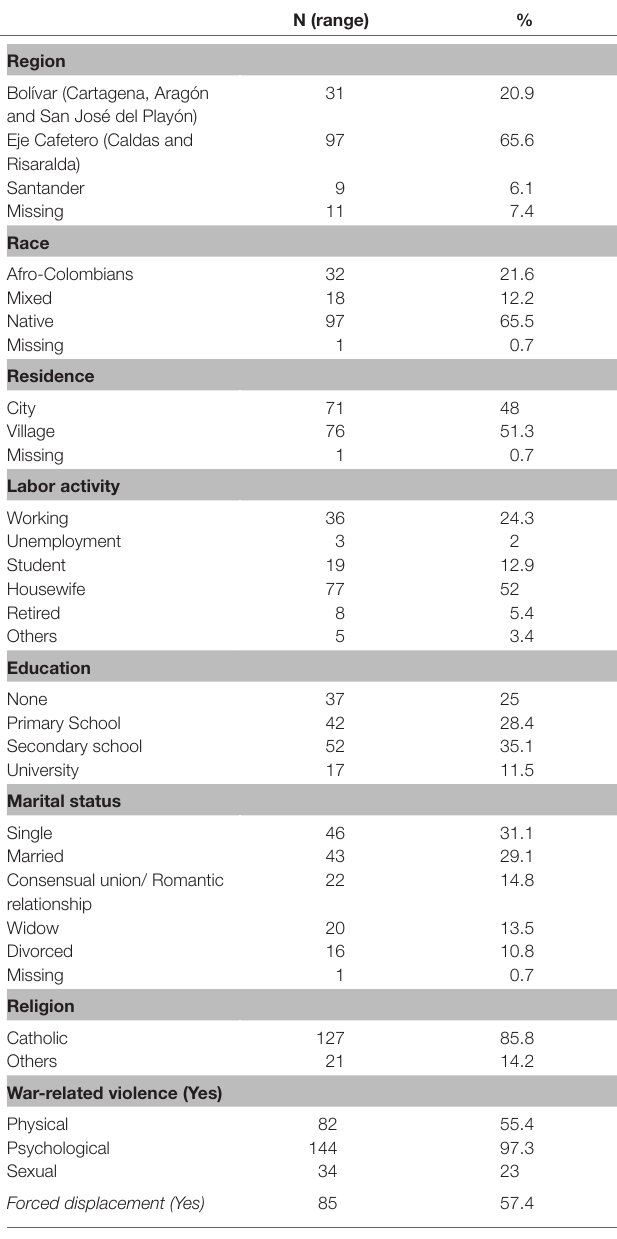
TABLE 1 | Descriptive analyses. Socio-demographic